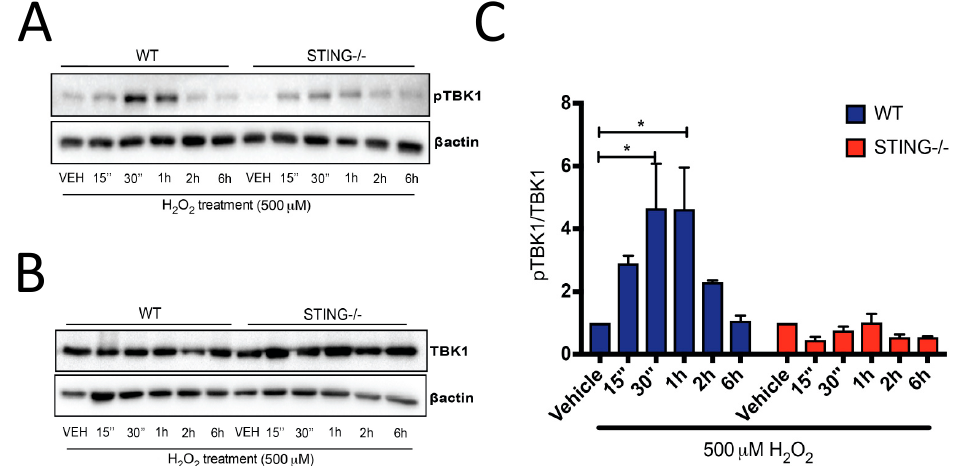
Figure 2. Activation of the downstream mediator of STING, TBK1, is increased following H 2 O 2 treatment. Western blot analysis confirmed increased phosphorylation of TBK1 (pTBK1) ( A ) in WT MEF SV40 cells following treatment with 500 µ M H 2 O 2 , with levels unchanged in STING − / − MEF SV40 cells (representative blot of n = 4 blots). Total TBK1 expression ( B ) was unchanged by H 2 O 2 treatment in both cells (representative blot of n = 4 blots). Quantification of ( A ) and ( B ) is shown in ( C ), demonstrating an increase in pTKB1 expression relative to total TBK1 levels in H 2 O 2 -treated WT MEF SV40 cells. Data represent the mean ± SEM, * p < 0.05.